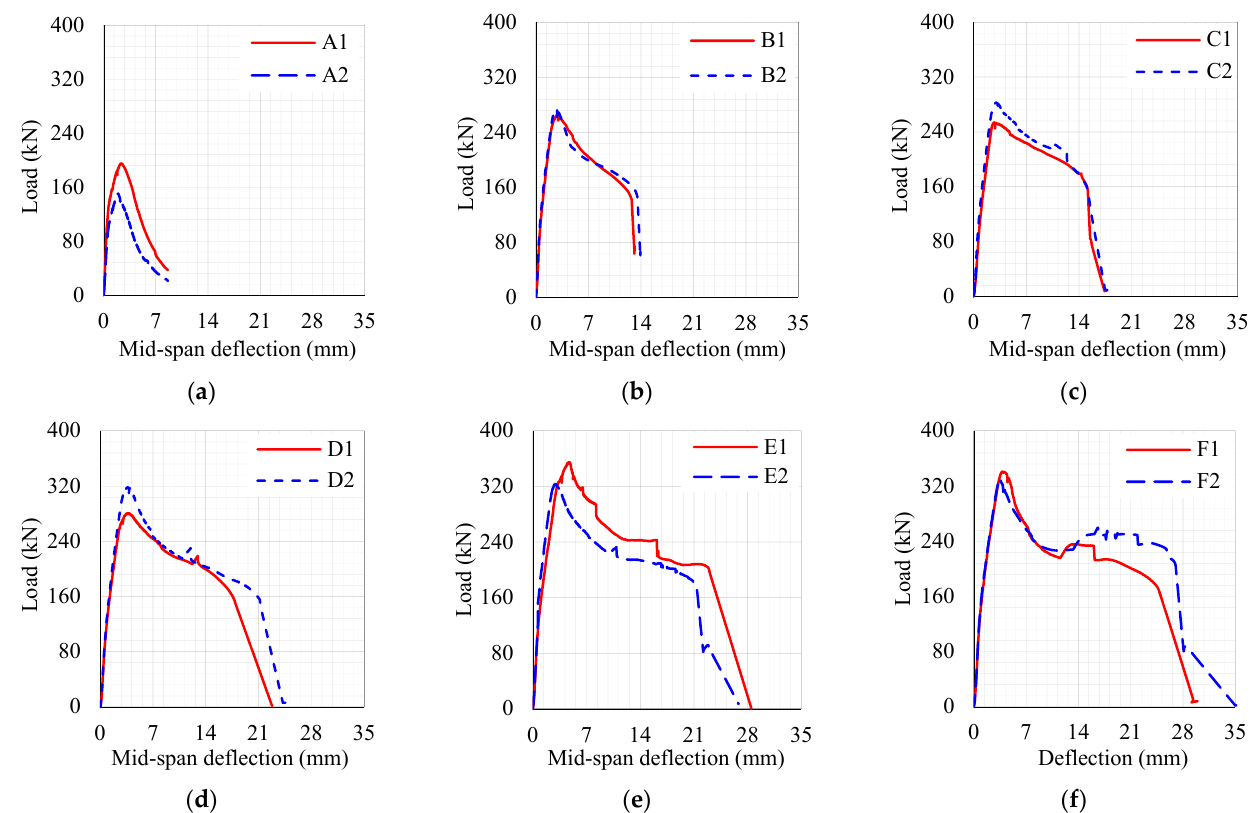
Figure 9. Load mid-span deflection responses for ( a ) A, ( b ) B, ( c ) C, ( d ) D, ( e ) E, and ( f ) F UHPC beams.